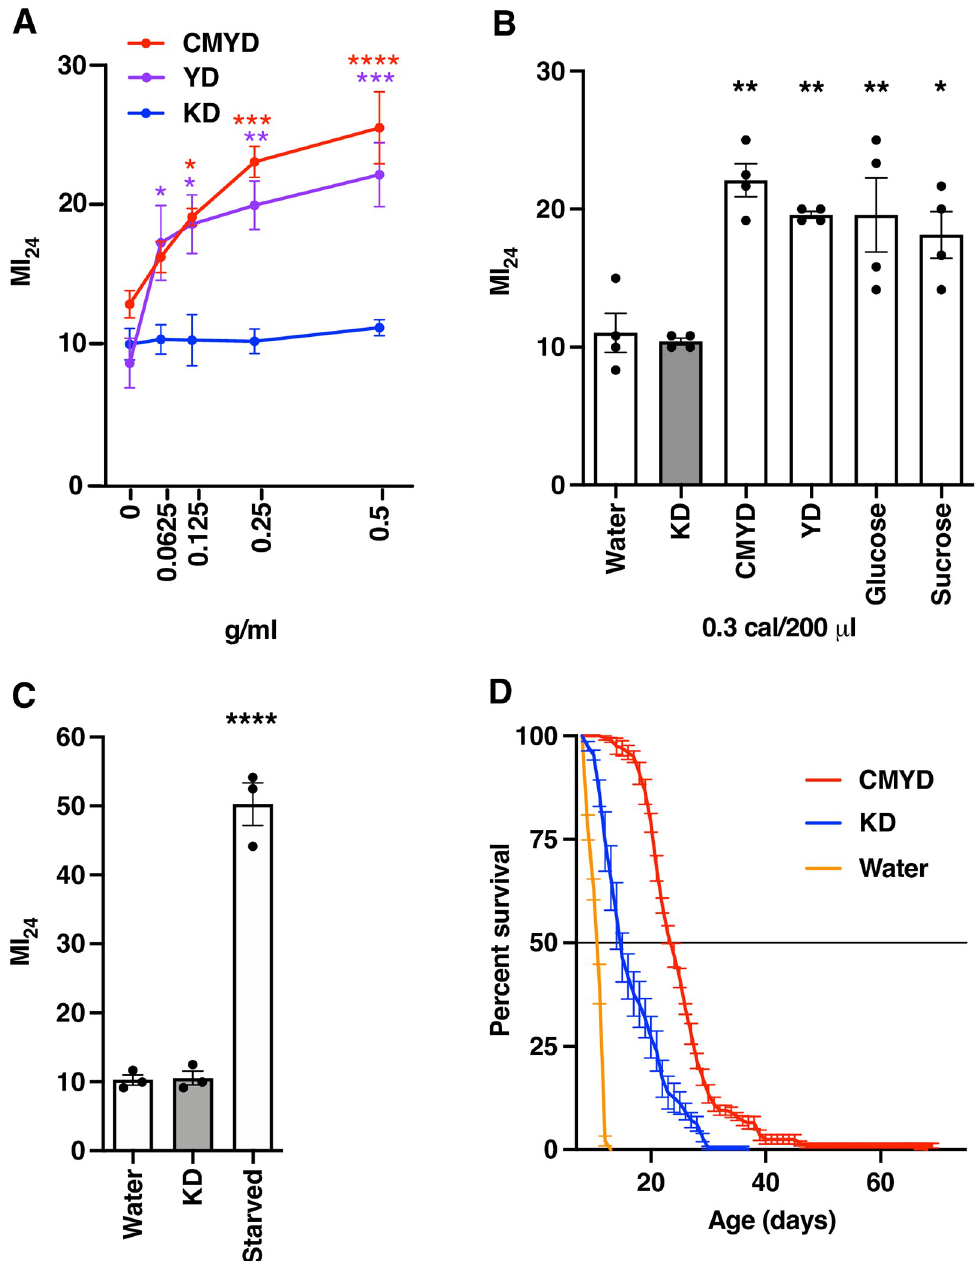
Fig 1. Analysis of the effect of CMYD, YD, and KD on the MI 24 . (A) Dose-response analysis of the effect of CMYD, YD, and KD on the MI 24 . The MI 24 represents the percent mortality of injured flies minus the percent mortality of uninjured flies 24 h following TBI. MI 24 values were determined for 0–7 day old, mixed sex w 1118 flies fed CMYD, YD, or KD at the indicated concentrations following TBI. At least three biological replicates of 60 flies were tested for each condition. Dots indicate the average MI 24 , and error bars indicate the standard error of the mean (SEM). (B) MI 24 values were determined for 0–7 day old, mixed sex w 1118 flies fed water or CMYD, YD, KD, glucose, or sucrose at 0.3 cal/200 μ l following TBI. Dots indicate biological replicates of 60 flies, bars indicate averages, and error bars indicate the SEM. (C) MI 24 values were determined for 0–7 day old, mixed sex w 1118 flies fed water, 0.3 cal/200 μ l KD, or no food or water (starved) following TBI. Dots indicate biological replicates of 60 flies, bars indicate averages, and error bars indicate the SEM. (D) Percent survival was determined for uninjured 0–7 day old, mixed sex w 1118 flies fed water (n = 240) or 0.3 cal/200 μ l CMYD (n = 200) or KD (n = 239) over the course of the experiment. Error bars indicate the SEM, and the horizontal line at 50% indicates the median lifespan. Significance for panels A, B, and C was determined using ordinary one-way ANOVA with Dunnett’s Multiple Comparison test. � p < 0.05, �� p < 0.01, ��� p < 0.001, and ���� p < 0.0001.